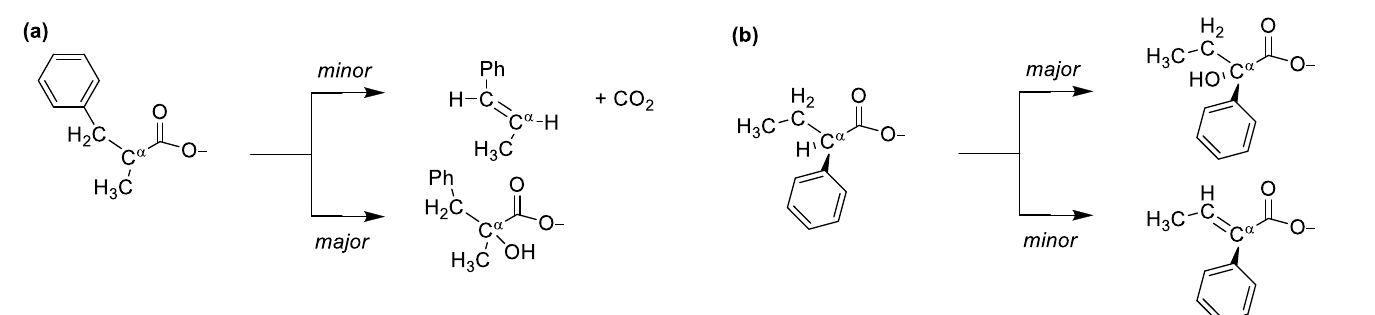
Scheme 2. Substrate activation of phenyl-substituted fatty acids by P450 OleTJE: ( a ) Activation of 2-methyl-3- Scheme